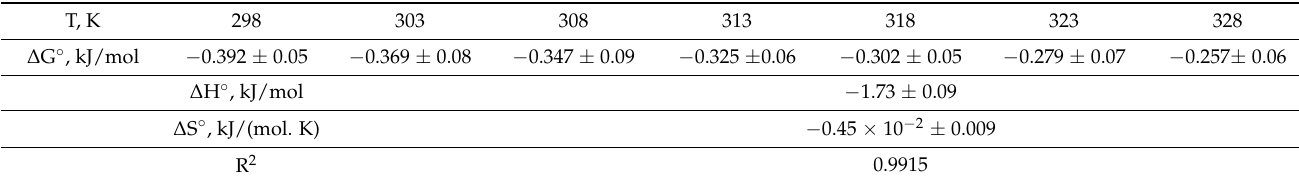
Table 5. Thermodynamic U(VI) adsorption settings at SiO 2